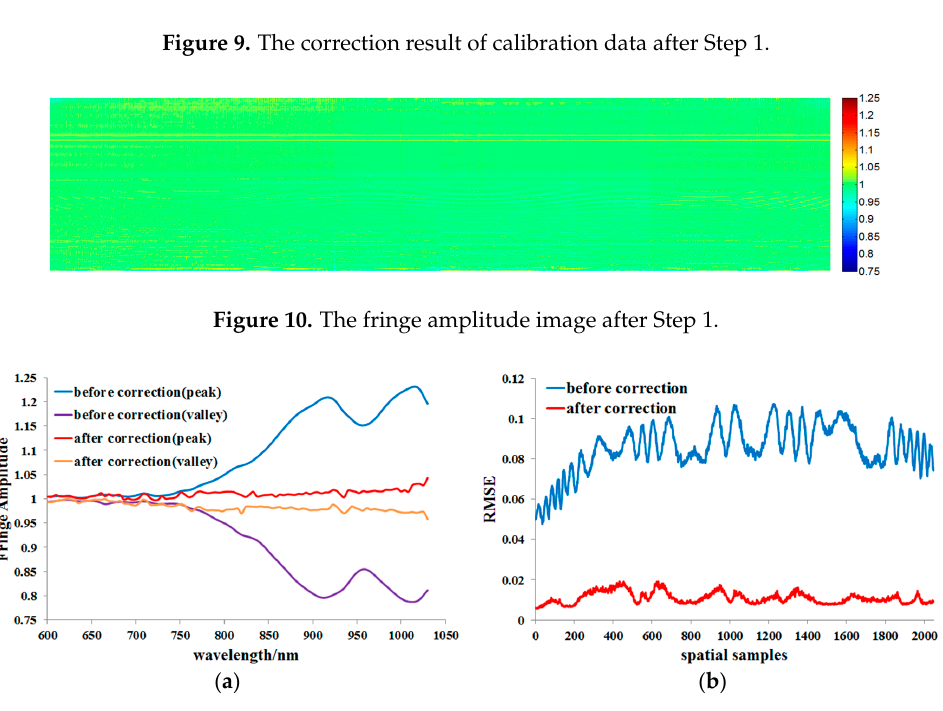
Figure 11. ( a ) The peak and valley fringe amplitudes before and after correction; ( b ) RMSE is calculated for each column of the fringe amplitude image before and after correction. for each column of the fringe amplitude image before and after